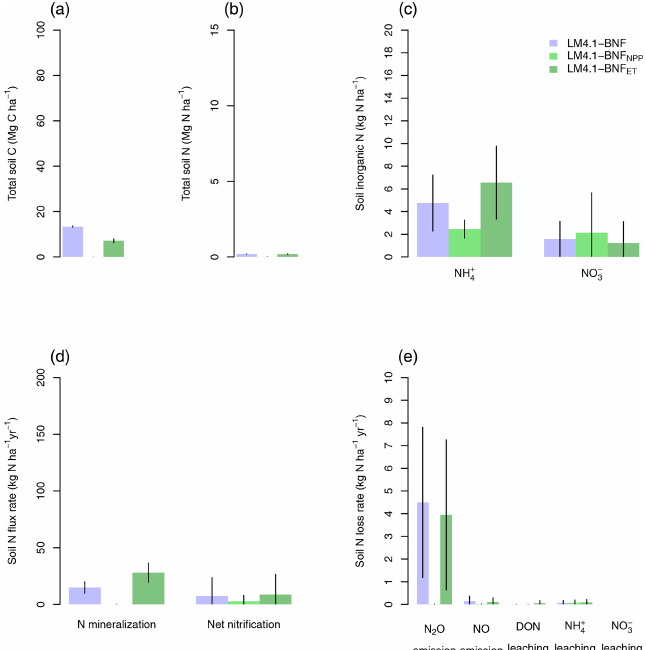
Figure D5. Simulated soil C and N pools, soil N fluxes, and soil N loss rates from LM4.1-BNF, LM4.1-BNFNPP, and LM4.1-BNFET. (a) Simulated total soil C (depth 0–10cm). (b) Simulated total soil N (depth 0–10cm). (c) Simulated soil NH + N mineralization rate and net nitrification rate (depth 0–10cm). (e) Simulated N 2 O and NO emission rate and simulated dissolved organic N (DON), NH + , and NO − leaching rate. Simulated data are averaged over the last 100 of the 300 years of simulation to reflect the site data 4 3 which are from mature forests. Error bars indicate 2 standard deviations.